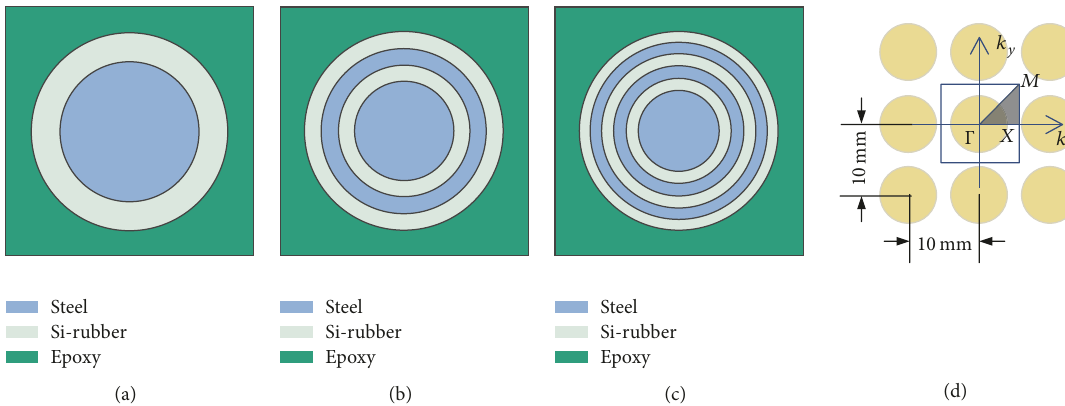
Figure 1: Cross-sectional views of 2D acoustic metamaterials in single-oscillator, dual-oscillator, and triple-oscillator systems (a–c); units in squarelatticearrangement(latticeconstant=10 mm)andschematicdiagramofthefirstBrillouinzone(d). Note .Shadedareaistheirreducible Brillouin zone. Points Γ , 𝑋 , and 𝑀 are irreducible Brillouin